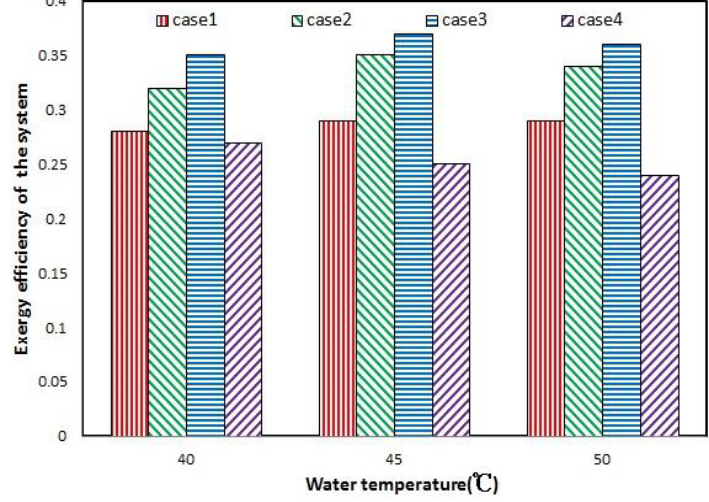
Figure 13. Average exergy efficiencies of four different evaporator water fluxes.